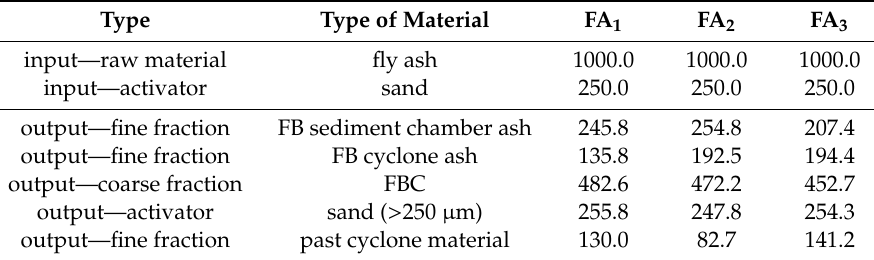
Table 1. FB separation mass balance, g.